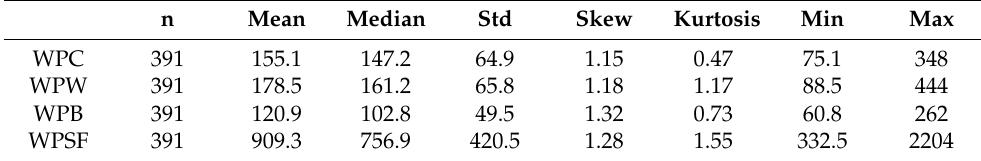
Note: This table reports summary statistics of the four agricultural commodities based on monthly observations. The table indicates the minimum (Min), maximum (Max), median, standard deviation (Std), skewness (Skew), kurtosis and the number of observations (n). The results were obtained in R studio using the “tseries” and “lessR” packages. However, the sample covers the entire period from 1 January 1990 to 1 August